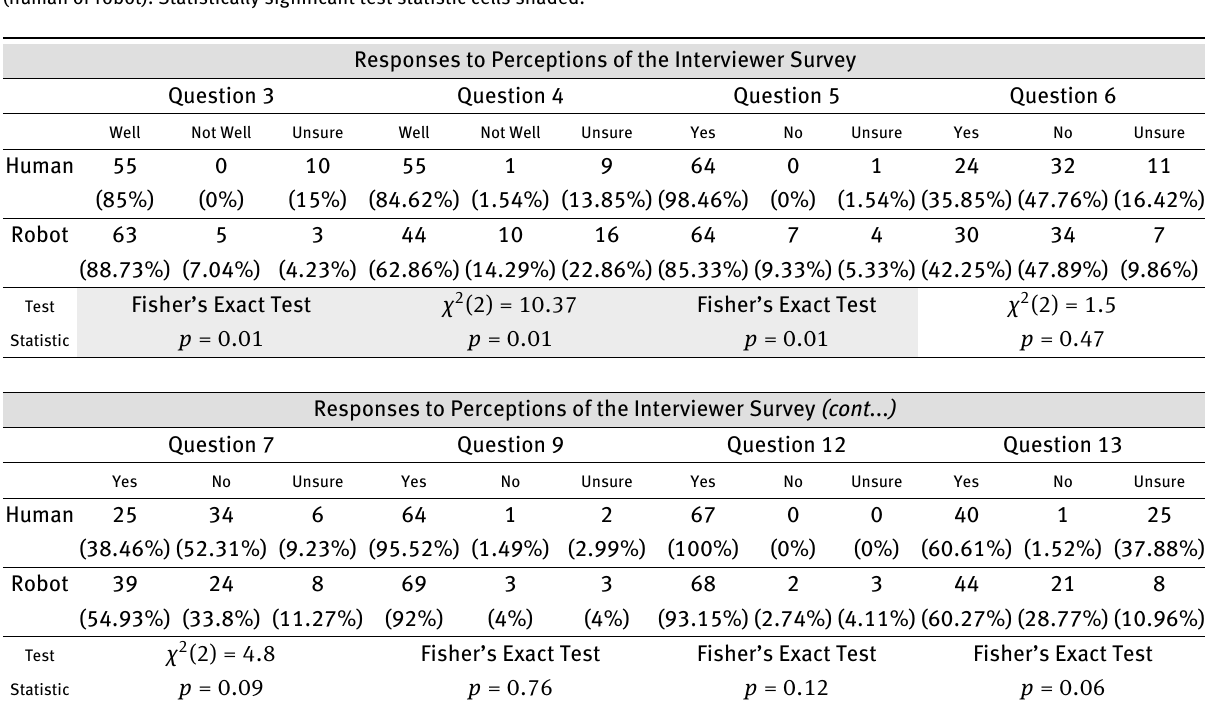
Table 3: Participant responses to Q3-Q7, Q9, Q12, and Q13 in the Perceptions of the Interviewer Interview categorized by interviewer type (human or robot). Statistically significant test statistic cells